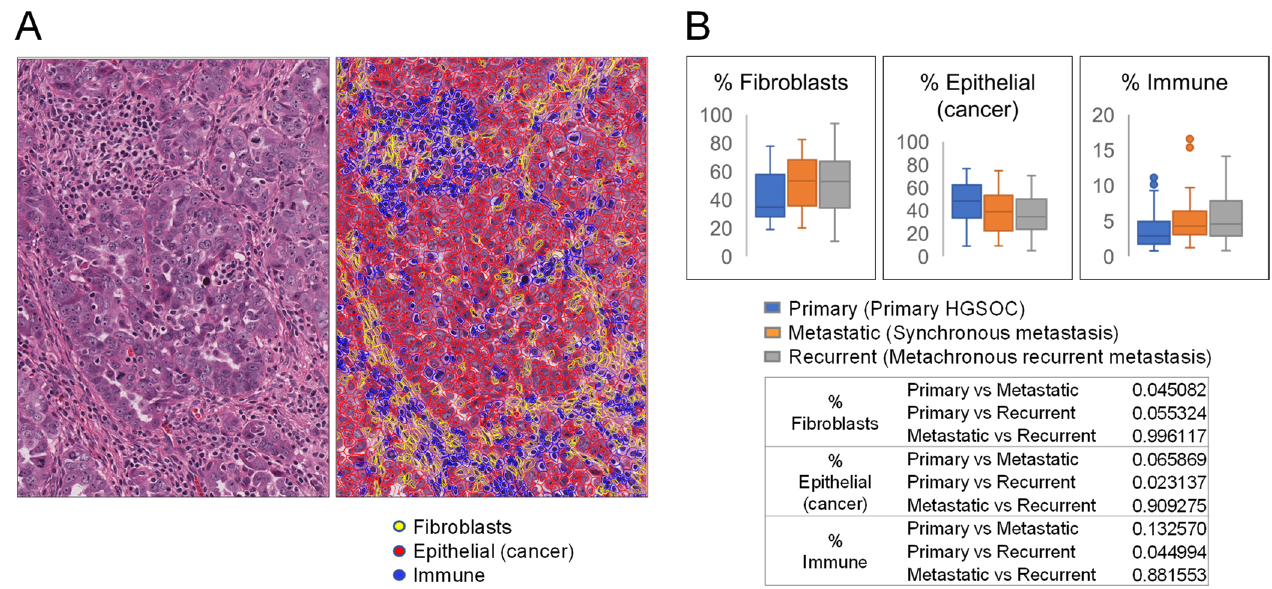
Figure 2. Percentages of fibroblasts, epithelial cancer cells, and immune cells in primary tumors and synchronous and metachronous metastases. ( A ) Example of H&E-stained HGSOC before and after annotation of fibroblasts, epithelial cancer cells, and immune cells by QuPath analysis. ( B ) Box and whisker plots show percentages of fibroblasts, epithelial cancer cells, and immune cells in primary HGSOC and synchronous and metachronous recurrent metastases. The Y -axis represents the percentage of a specific cell type among all detected cells. The table shows p values for comparisons between every two groups of samples within the three